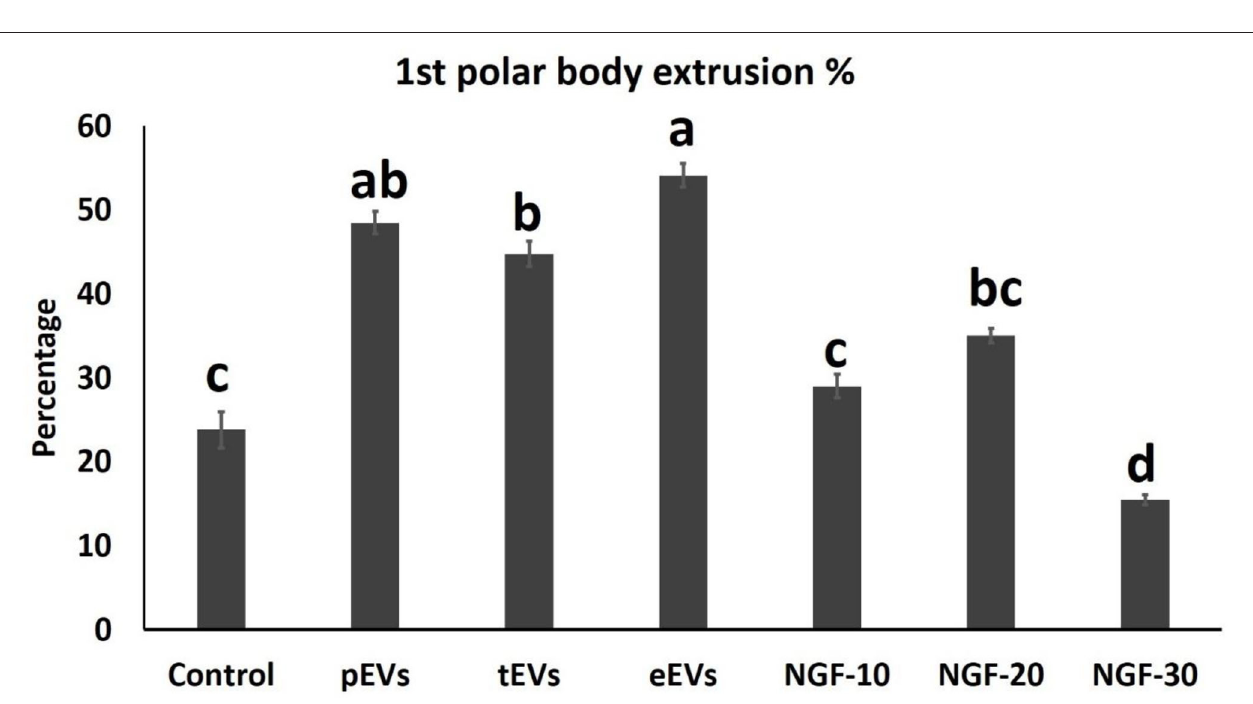
FIGURE 5 | Comparison between the first polar body extrusion values in the oocytes from different experimental groups. Different letters indicate a significant difference at p < 0.05.